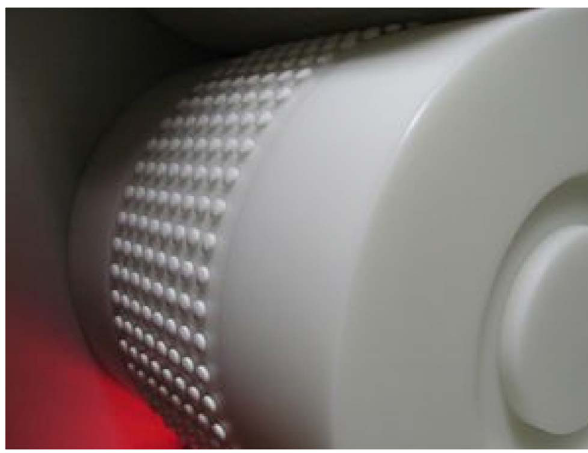
Figure 1. Mechanically constrained inspected products on an automated inspection